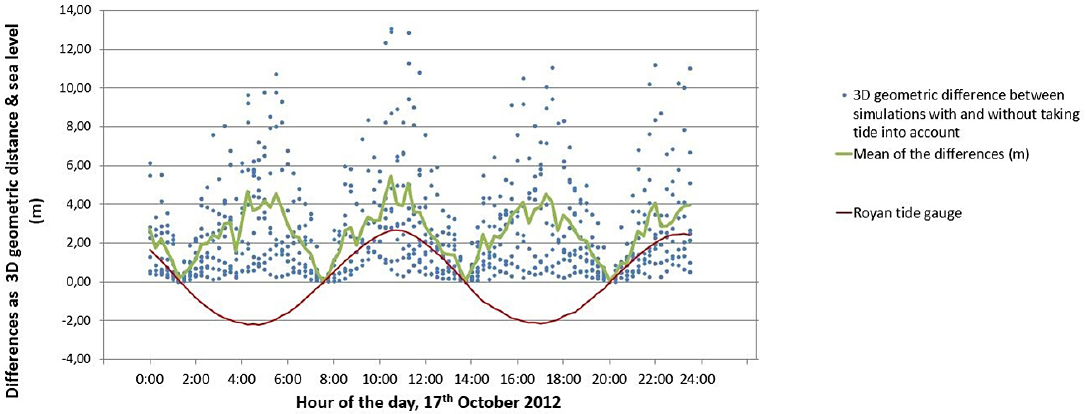
Figure 10. Assessment of the tidal influence. The impact of the tide on the size of the reflecting area is non-negligible (decametric 3-D differences), and it is worth noticing that the gaps would have been even bigger by integrating satellites with low elevation angles. Note also that the periodic variations of the 3-D differences are only linked to the tide, since the mean of the satellite elevation angles does not show periodic variations during the day of the simulation (43 . 3 ± 3 . 5 ◦ over the